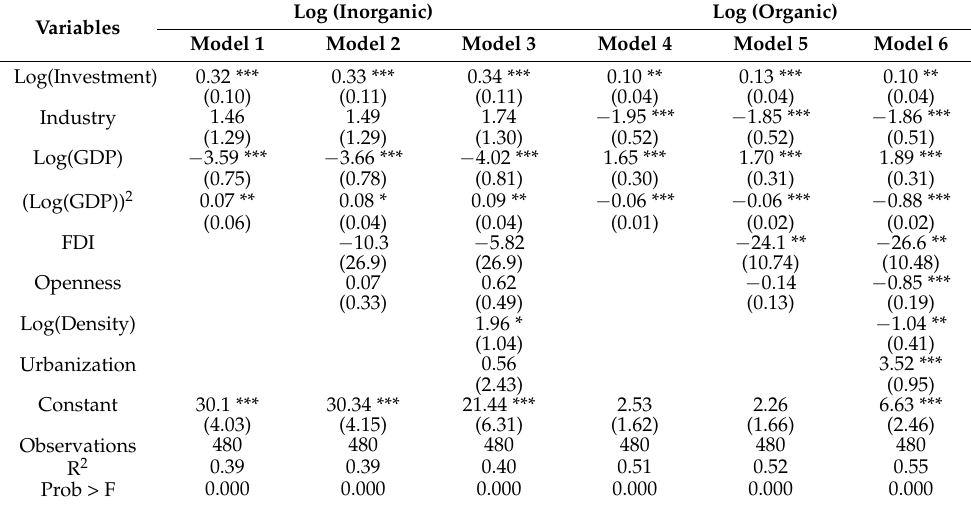
Table 3. Estimation Results of fixed effect